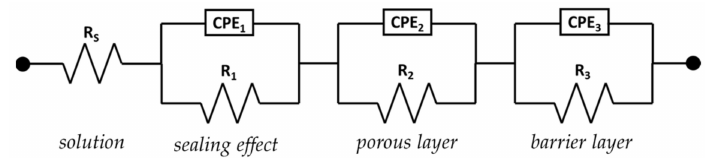
Figure 4. The proposed electrical equivalent circuit (EEC) model.